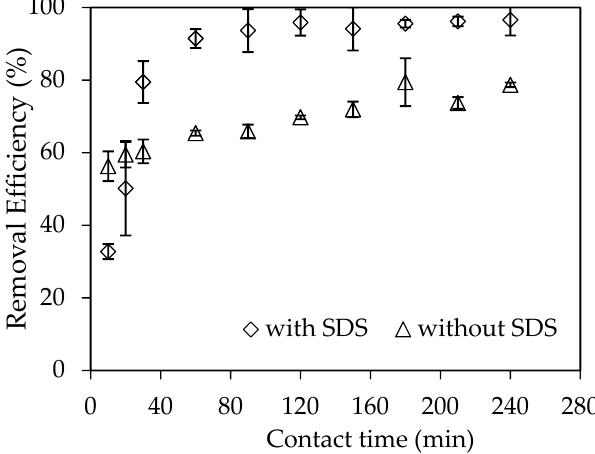
Figure 8. The effect of contact time on RhB removal using synthesized nano γ -Al 2 O 3 without SDS modification (Temperature 25 ± 2 °C, C i (RhB) = 10 − 6 M and with SDS modification ( C i (RhB) = 10 − 4 M).